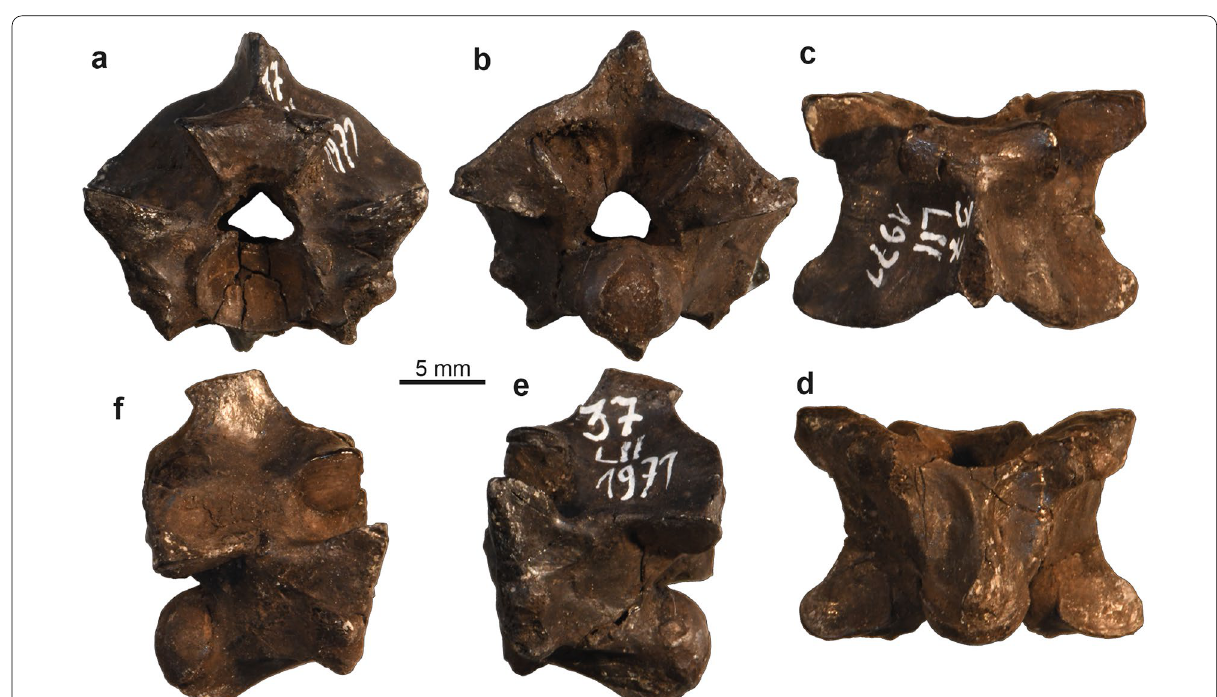
Fig. 20 Palaeopython ceciliensis from quarry LII, Geiseltal: mid-trunk vertebra (GMH LII-37-1971) in anterior ( a ), posterior ( b ), dorsal ( c ), ventral ( d ), left lateral ( e ), and right lateral ( f ) views